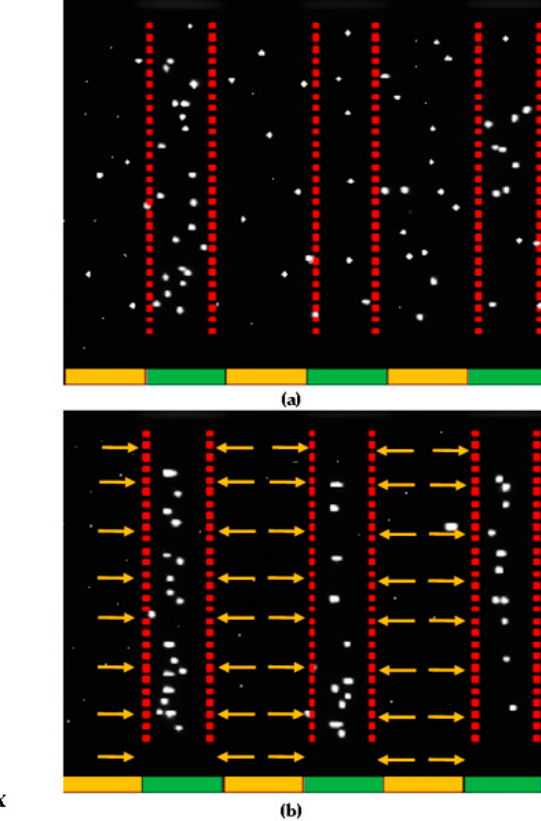
Figure 19. Top view of the micro fl uidic channel with the ferro fl uid: ( a ) Image of 10 µm and 1 µm diameter microspheres randomly dispersed in the channel and ( b ) After the excitation, particles collect in the interelectrode spacing. The electrode (gold) and spacing (green) are shown below the fi gures.